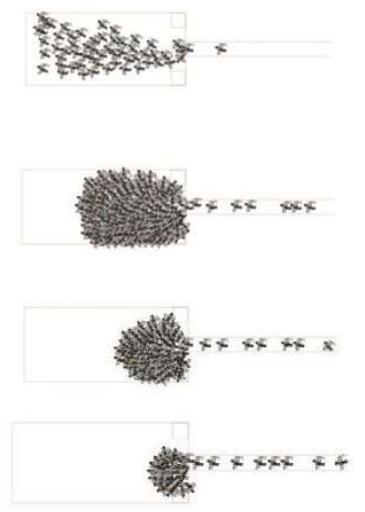
Figure 4. Process of pedestrians into arch and dissipation.